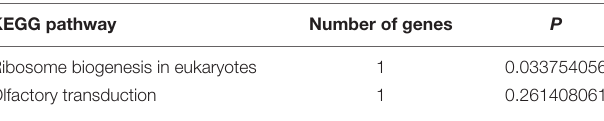
TABLE 6 | Top significantly enriched Kyoto Encyclopedia of Genes and Genomes (KEGG) pathways of target genes of differentially expressed long non-coding